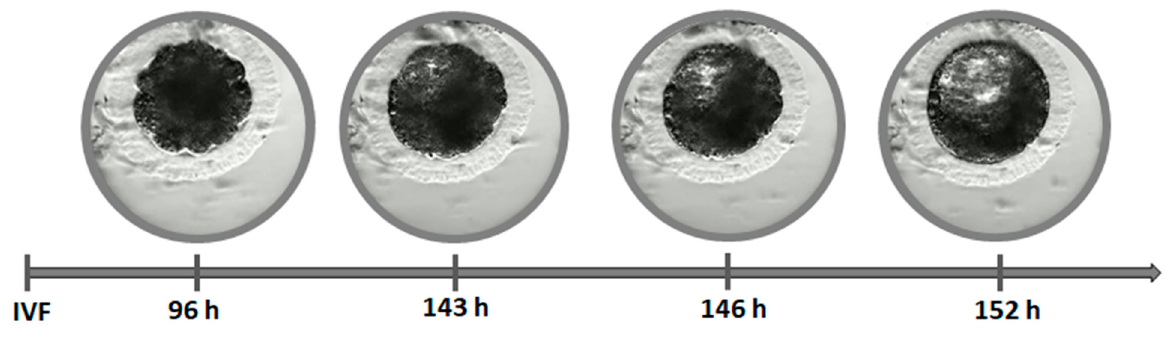
Figure 5. Timing of blastocyst hatching. 4. Discussion Recently, many studies have indicated that the timing of the first embryonic cleavage is a simple and noninvasive method that can be used as an early indicator for selecting good quality embryos, as shown in cattle [25], humans [26] and sheep [20,27]. In some studies, to eliminate error associated with variation in the time of sperm entry, the timing of pronuclear fading (tPNF) was proposed as a reference starting time [28]. In the case of cats, it is not possible to assess the formation or disappearance of pronuclei in oocytes because of their dark cytoplasm. In our study (Figure 1), feline embryos that cleaved rel- atively early (21–24 hpi) were more developmentally competent compared with those that cleaved later (>25 hpi) ( p < 0.001). Although the earliest initiation of first cleavage was observed at 17 hpi, these embryos had a very poor rate of development to the blastocyst stage (2%). These results are in accordance with previous studies in several species such as cattle [16,19,20,29]. In cats, the relationship between the timing of the first cleavage on embryo developmental competence has not been examined using a time-lapse system, only via traditional observation of embryonic development at 18,24 and 30 hpi [12], or 27 and 42 hpi [21]. Ochota and co-workers [12] reported that the best quality embryos cleaved before 18–24 hpi, while none of the embryos that cleaved between >24–30 hpi reached the